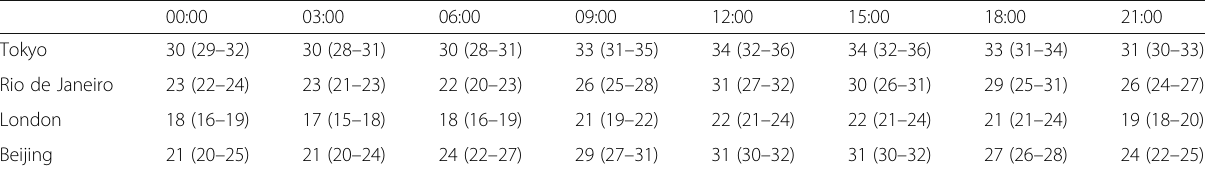
Table 2 Wet-bulb globe temperature (WBGT) by time of day in the previous three Summer Olympics and the expected periods of the Tokyo 2020 Summer